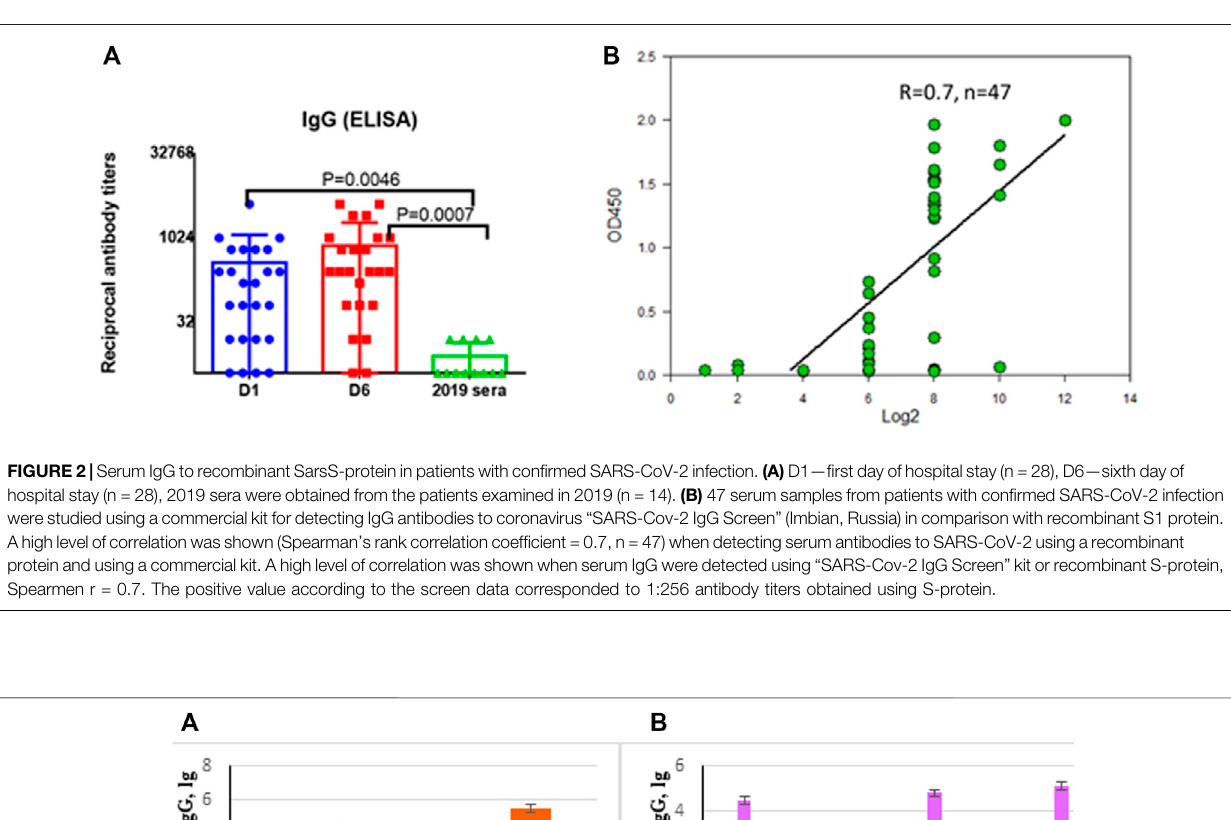
Frontiers in Pharmacology |